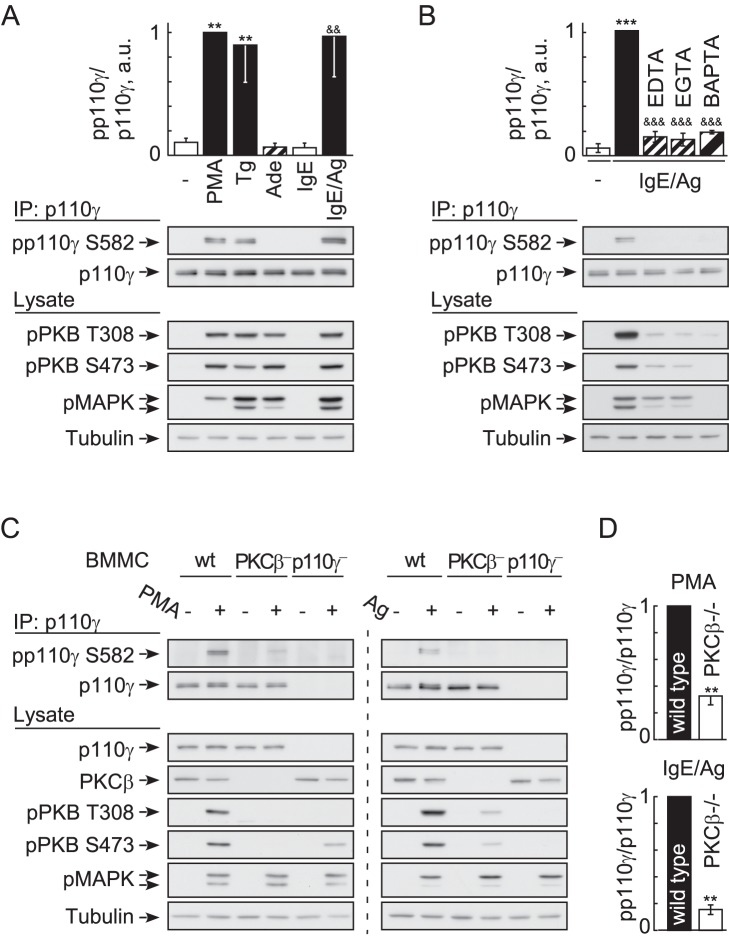
Phosphorylation of PI3Kγ requires Ca2+ and is PKCβ-dependent.(A) Stimulus-induced phosphorylation of endogenous p110γ on Ser582 in wild type BMMCs. IL-3 deprived cells were stimulated with 100 nM PMA, 1 µM thapsigargin, 1 µM adenosine, or 20 ng/ml DNP for 2 min. Where indicated (IgE), BMMCs were loaded with IgE (100 ng/ml) overnight. PI3Kγ was immunoprecipitated from cell lysates with an anti-PI3Kγ antibody, before precipitated protein was probed for phosphorylated p110γ (pp110γ) with a phospho-specific anti-pSer582 antibody (validation of antibody see Figure S4). PI3Kγ phosphorylation is shown normalized to total PI3Kγ levels (mean ± standard error of the mean [SEM], n = 3; * depict analysis using unstimulated control. & reference point is IgE only). (B) IgE/antigen-induced Ser582 phosphorylation of p110γ requires Ca2+ influx. Cells were stimulated as in (A), but exposed to EDTA, EGTA, or loaded with BAPTA/AM where indicated (see Figure 2). Phosphorylated p110γ was detected as in (A); mean ± SEM, n = 3; * comparison with unstimulated control; &analysis of stimulated versus chelator treated). (C) Phosphorylation of p110γ in wild type and PKCβ−/− BMMCs. Experimental settings were as in (A), and (D) depicts quantification of pp110γ in relation to total p110γ protein (mean ± SEM; PMA n = 4, antigen n = 3). Cells devoid of p110γ were included as negative control.